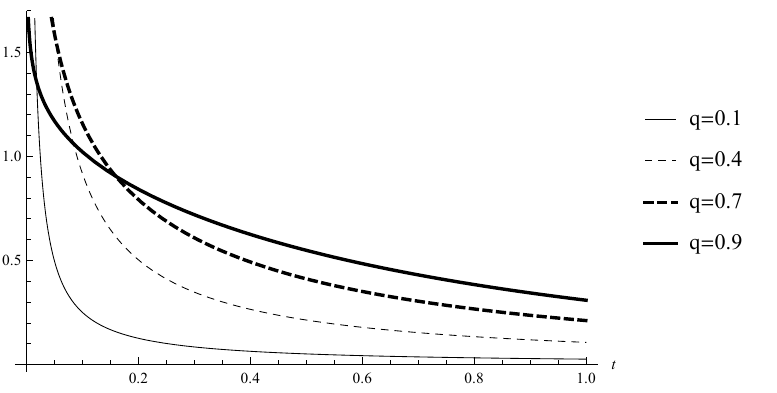
Figure 1. Example 1. Graphs of the solutions of (4) for a = − 1, x 0 = 1 and various fractional orders q